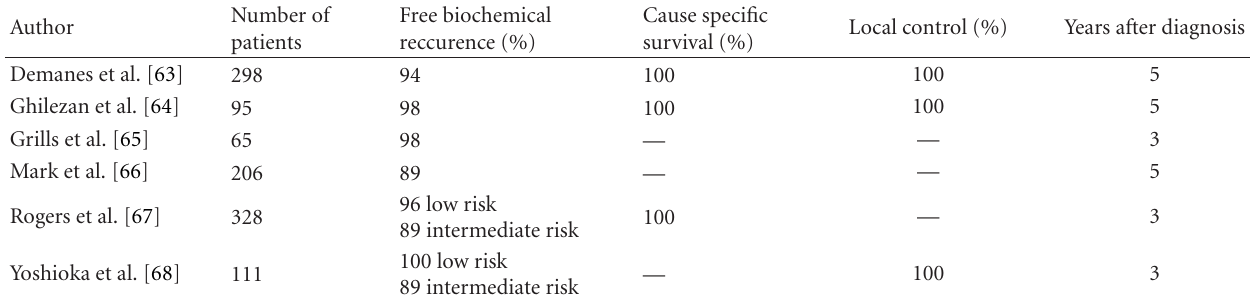
Table 5: Clinical results after HDR brachytherapy alone for patients with low- and intermediate-risk prostate